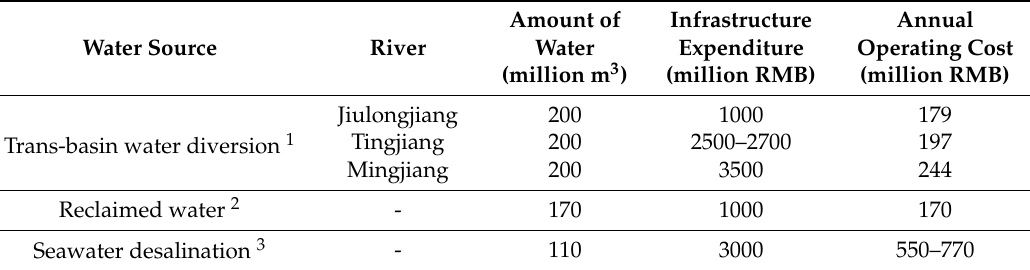
Table 3. Water supply sources for Xiamen